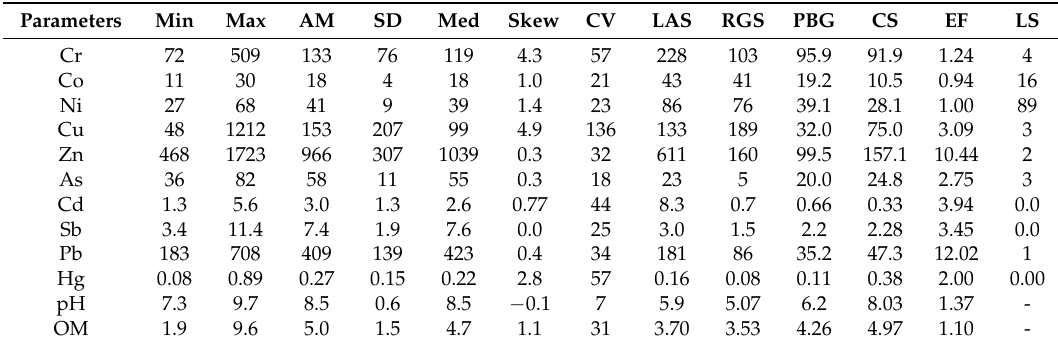
Table 3. Descriptive statics of trace metal(loid)s, pH and OM in street dust of Hezhang city ( n = 30) and soils and limestones in Guizhou